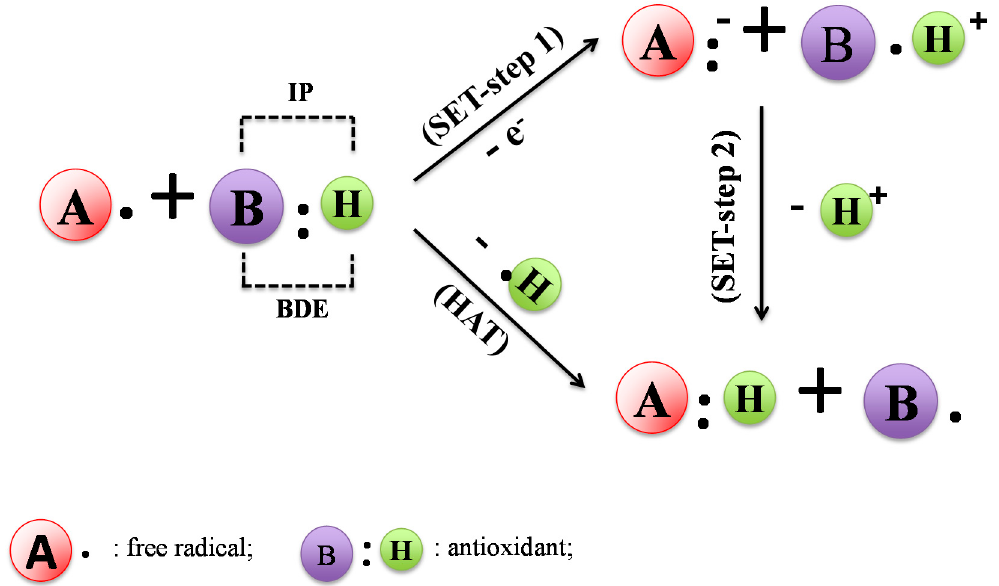
Figure 2. Mechanisms of antioxidant reacting with free radical: single electron transfer (SET) and hydrogen atom abstraction (HAT). In SET mechanism, the IP (ionization potential) of the antioxidant is the most important energetic factor in evaluating the antioxidant action. In the HAT mechanism, the BDE (bond dissociation enthalpy) of the antioxidant is the important parameter in evaluating the antioxidant